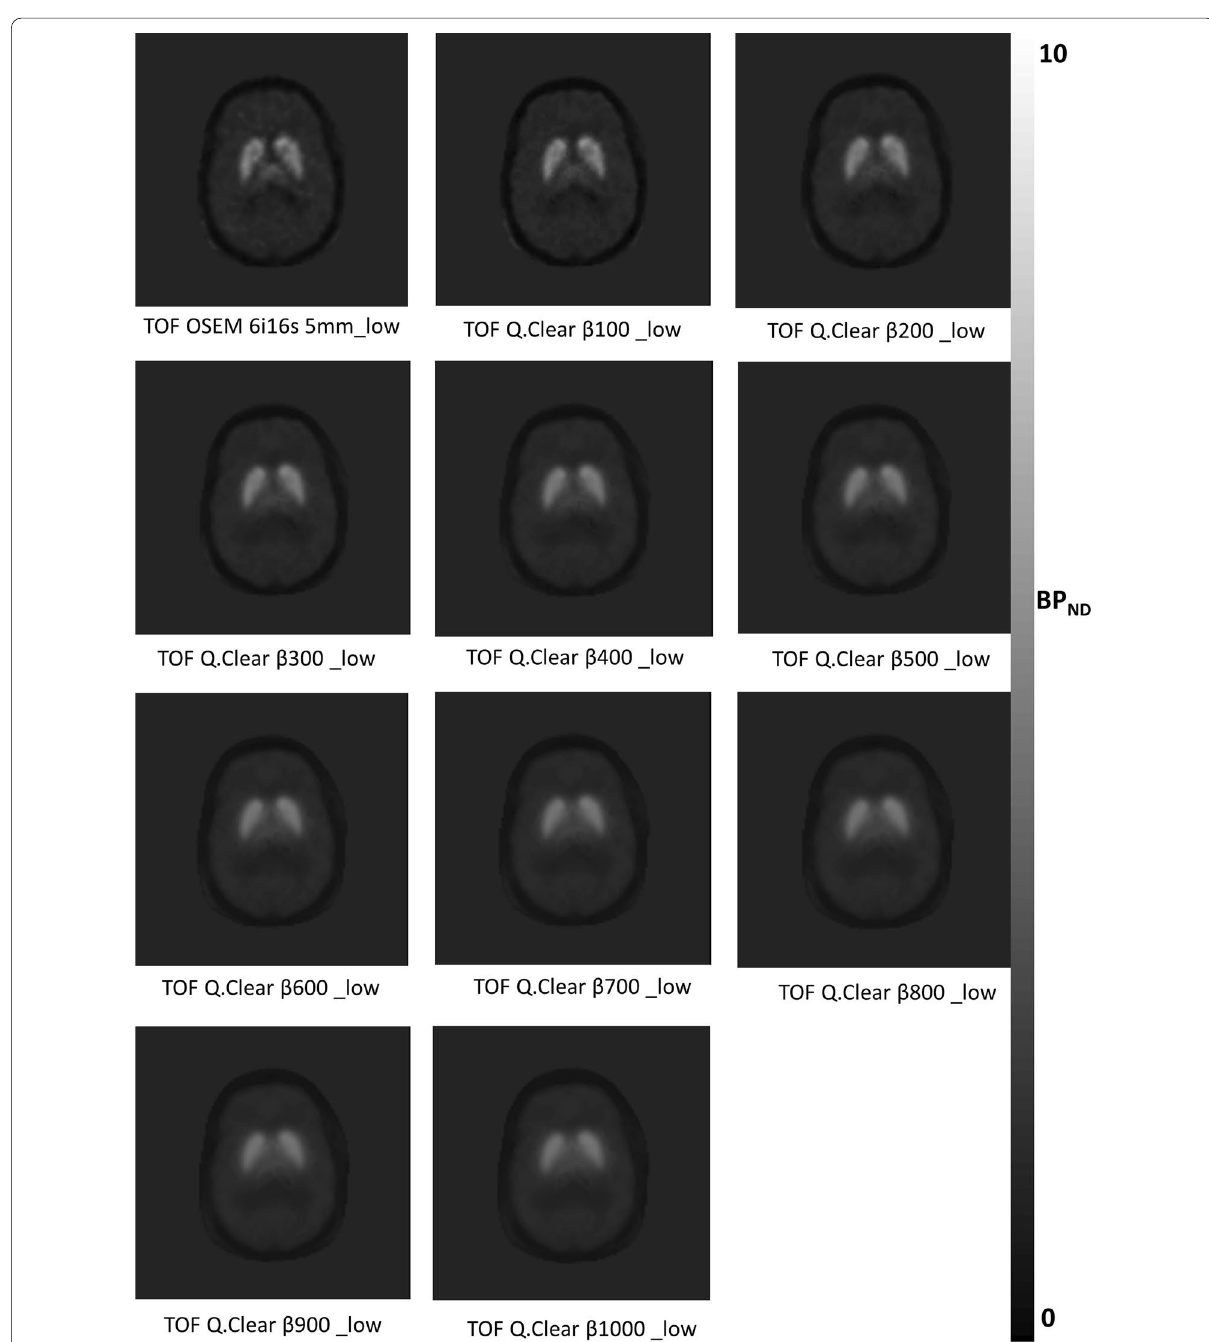
Fig. 2 Representative BP ND parametric brain images after [ 11 C]PHNO administration, per reconstruction method under low counts. Note the visual differences in image quality for the Q.Clear reconstructions as β